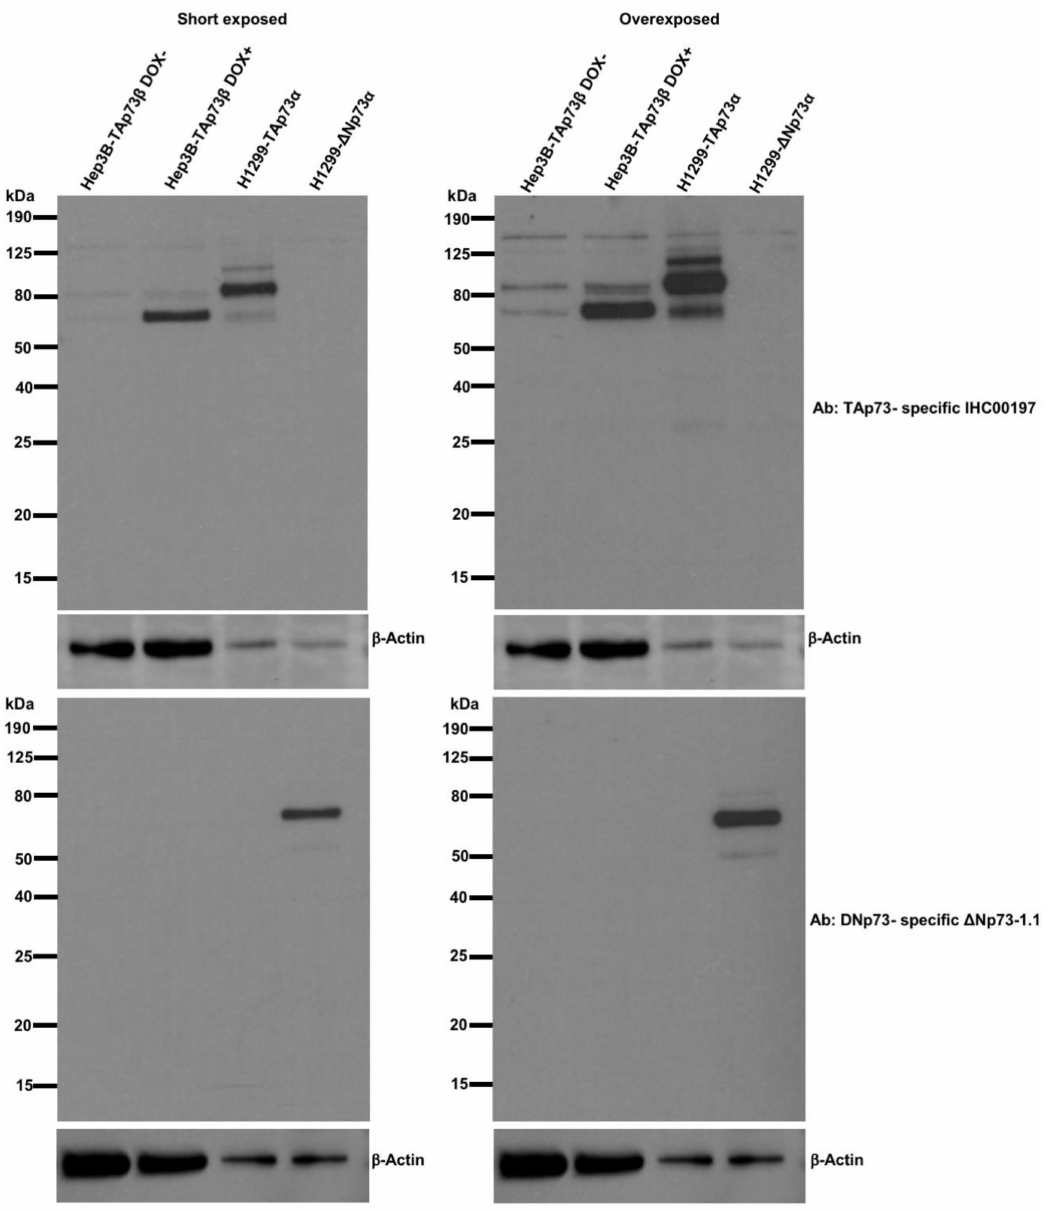
Figure 2. T-Rex-inducible expression in Hep3B cells resulted in TAp73 β overexpression, with no detectable expression of DNp73 protein. Hep3B cells with (Hep3BTAp73 β DOX+) or without (Hep3BTAp73 β DOX − ) doxycycline treatment were compared to H1299 transiently transfected with TAp73 α (H1299-TAp73 α ) or DNp73 (H1299-DNp73). Western blot analysis of cell lysates using IHC00197 antibody recognizing TAp73 isoforms (top panel) and western blot analysis of cell lysates using ∆ Np73-1.1 antibody recognizing DNp73 isoforms [31,32] (bottom panel). β -actin antibody was using as a loading